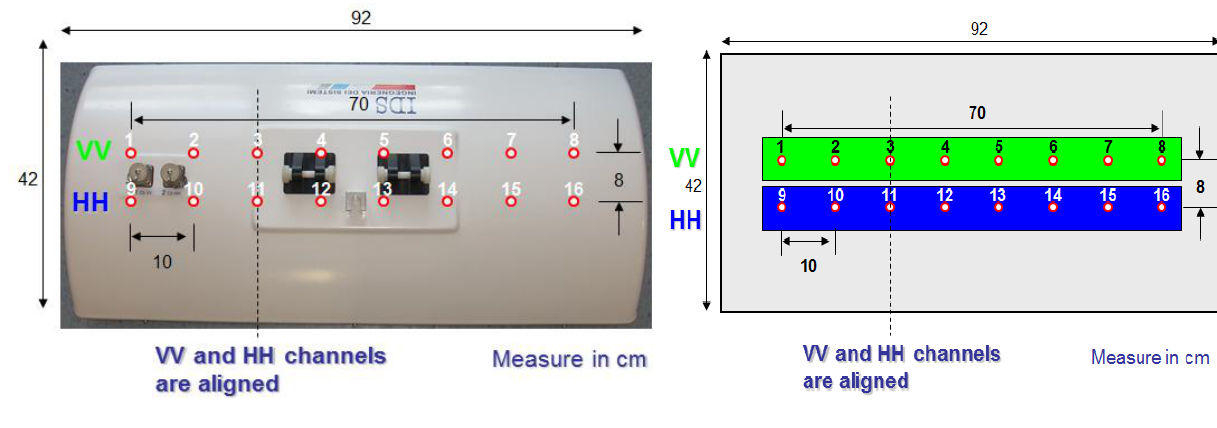
Figure 9. Split-spectrum processing (SSP) with order statistic rank filter ( f